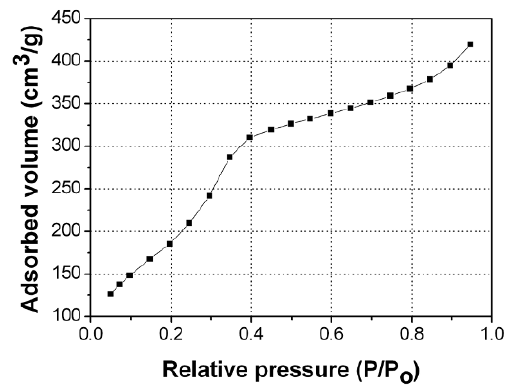
Figure 4. Low temperature nitrogen adsorption isotherm on the derived xerogel Si-10Al